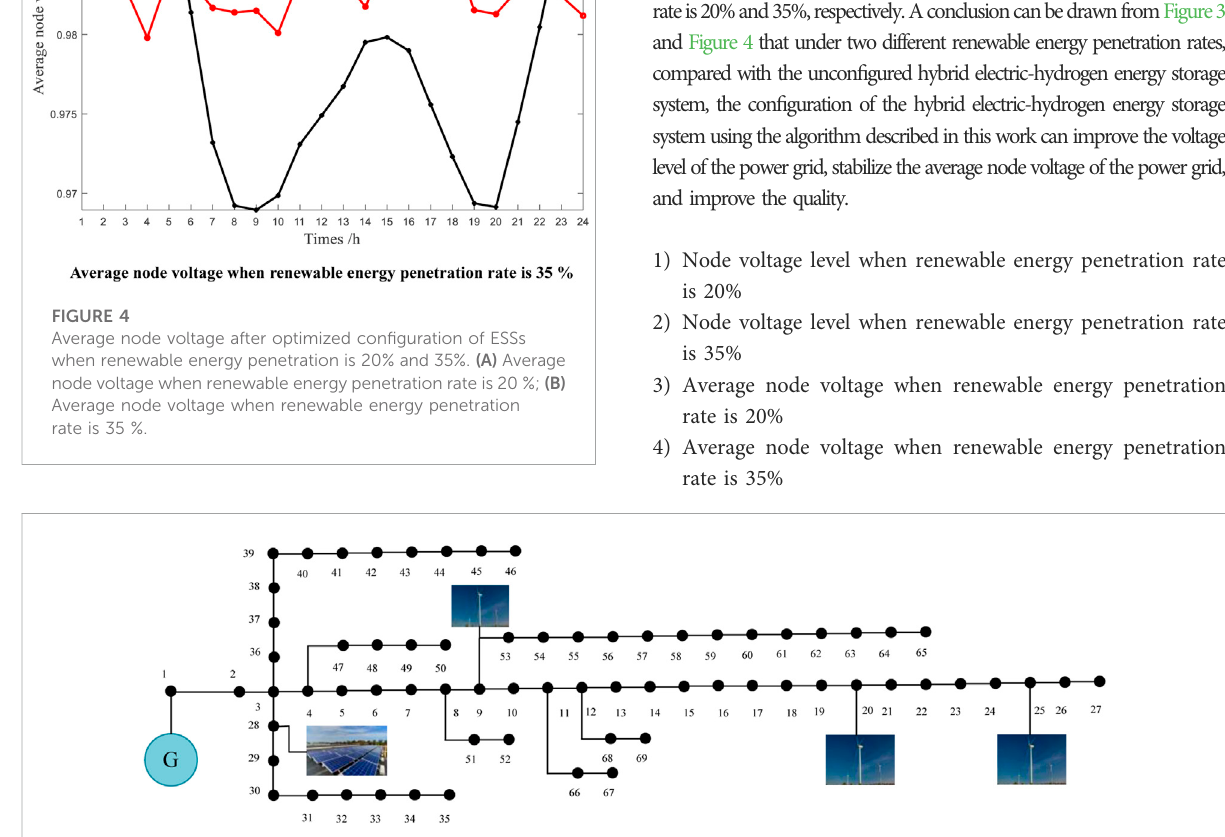
FIGURE 5 Topology of the extended IEEE-69